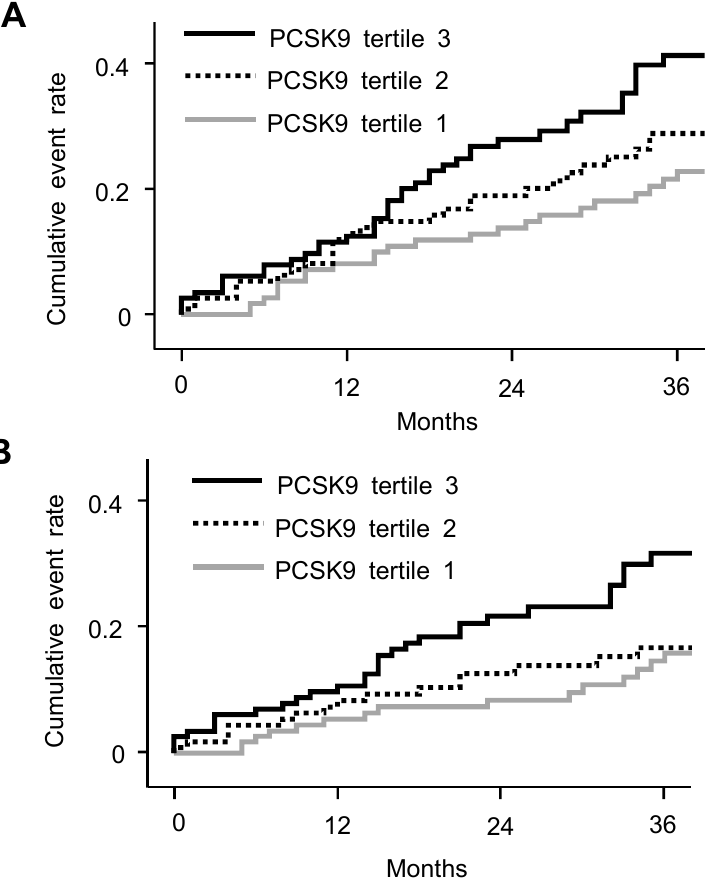
Figure 1. Cumulative event rates for composite of CV events and death ( A ) and CV events ( B ) according to the PCSK9 level.